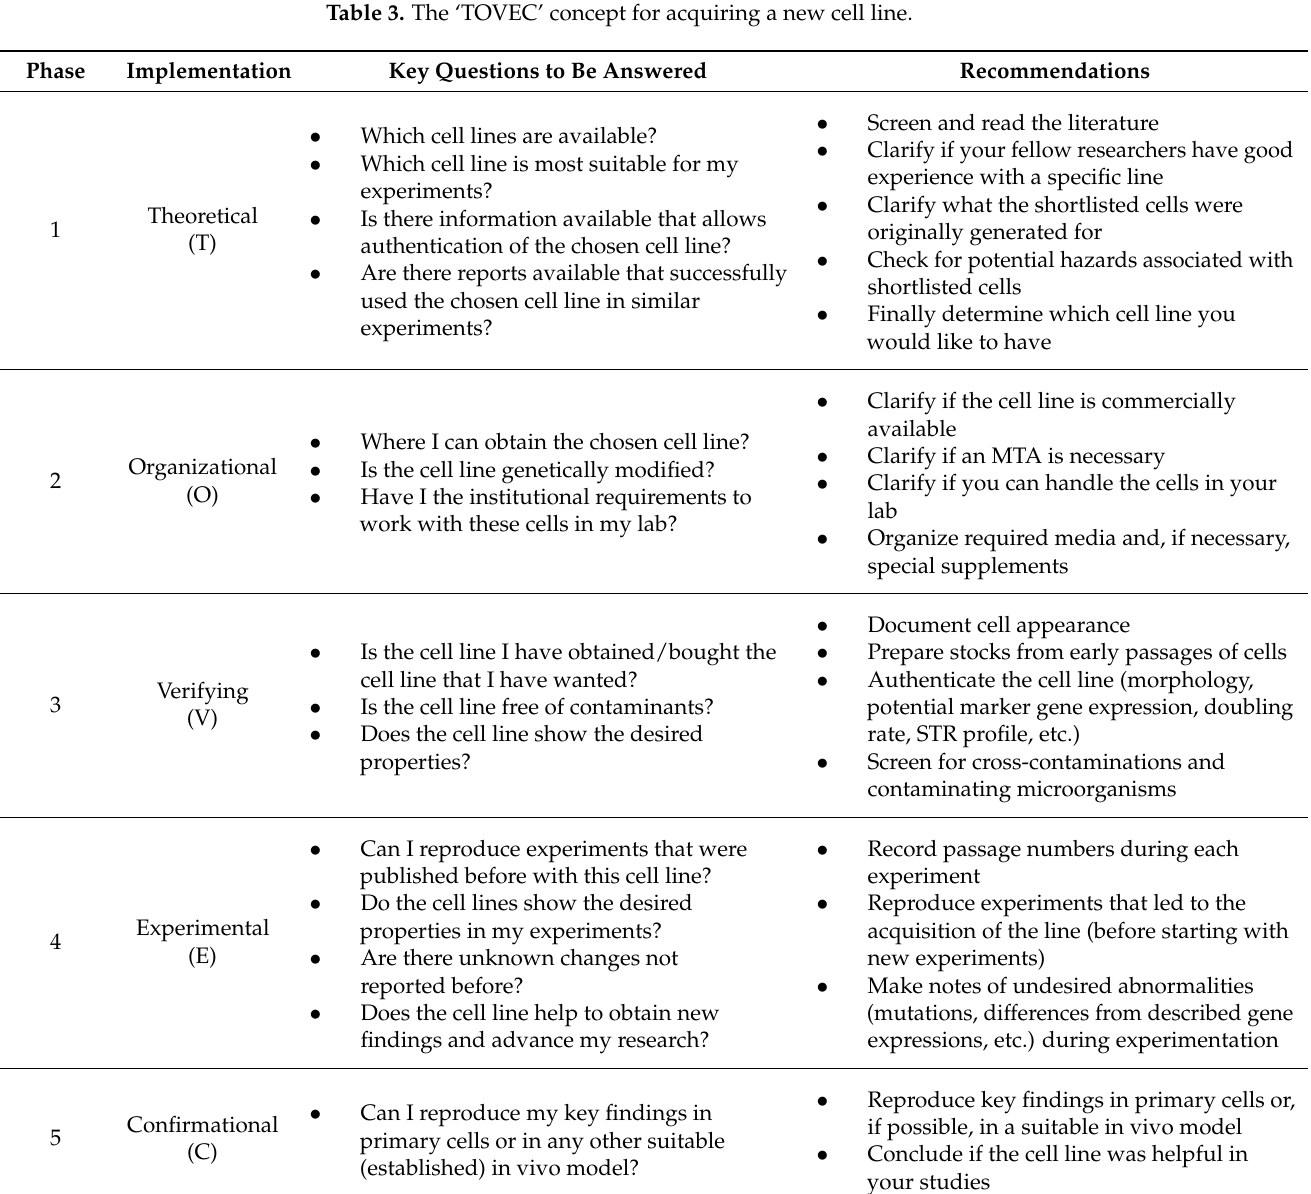
Table 3. The ‘TOVEC’ concept for acquiring a new cell